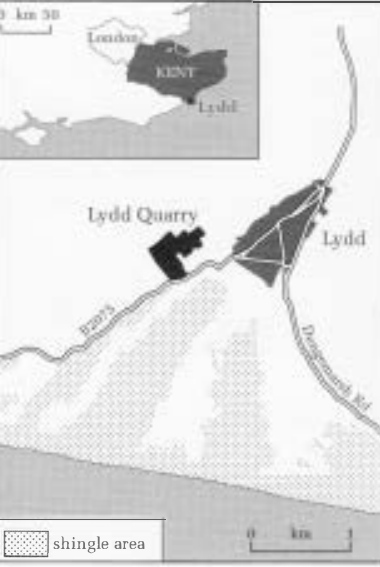
Figure 1 Location of Lydd Quarry,